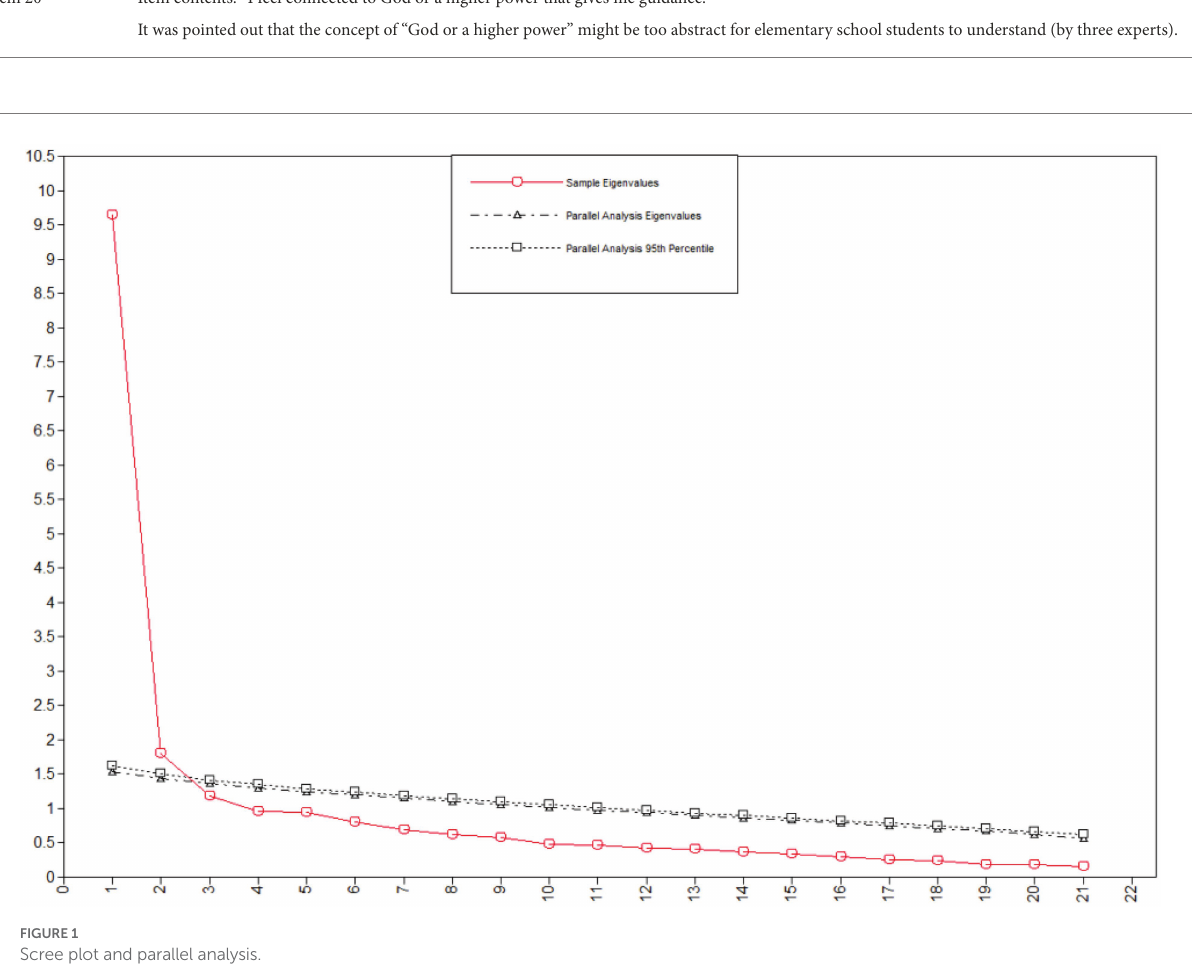
FIGURE 1 Scree plot and parallel analysis.